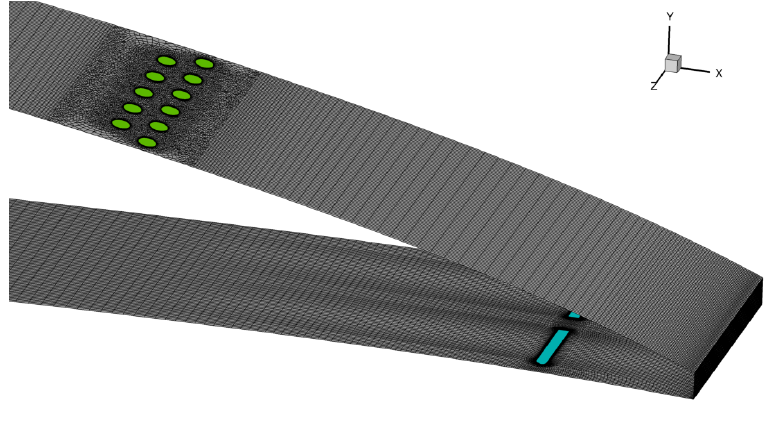
Figure 11. Detail of the CFD surface grid around trailing edge of the AR2 airfoil. The cyan surface represents blowing slots, the green color marks the circular suction holes.